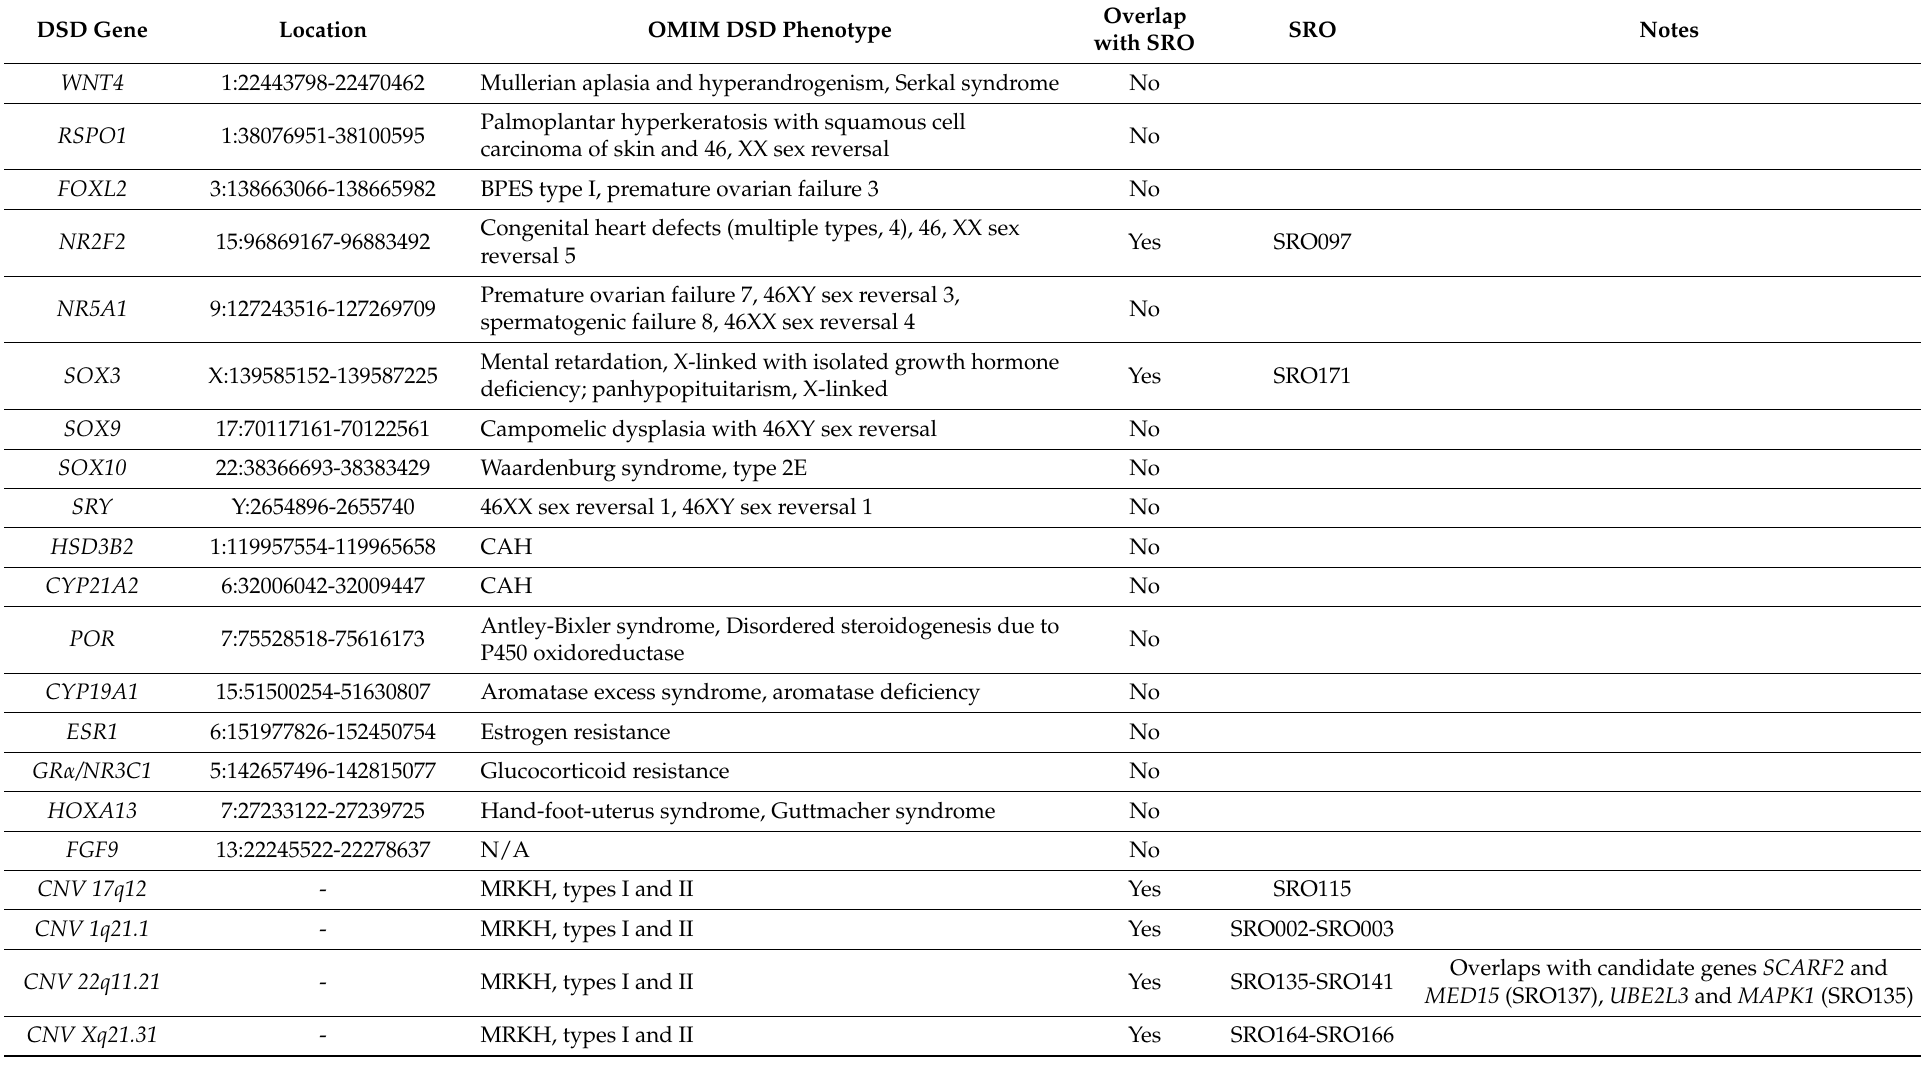
Table 1. Genes Known to be Associated with DSD 1